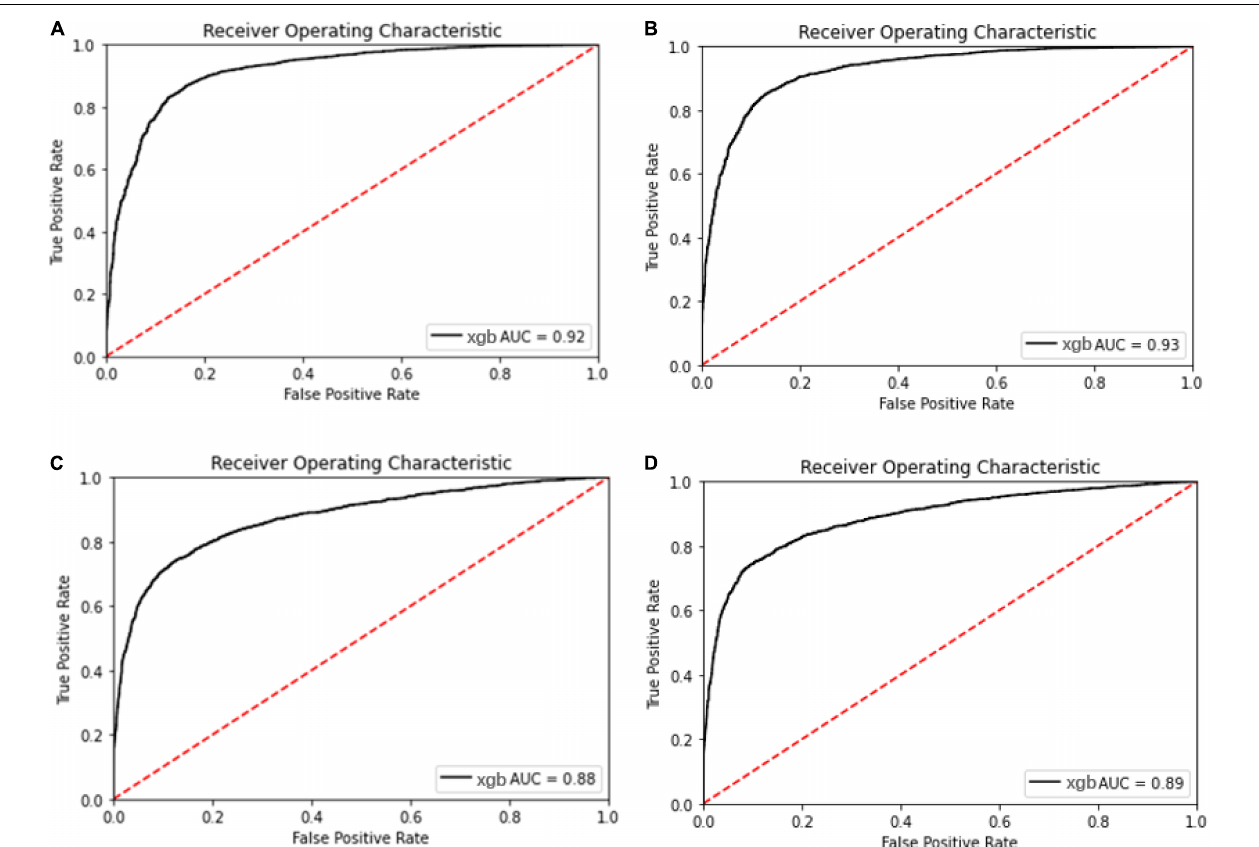
FIGURE 5 | Receiver operating characteristic curve for the oxacillin and clindamycin susceptibility prediction under replication cohort in multi-label learning model, respectively. The AUC is noted in the curve. (A) ROC for the oxacillin susceptibility prediction in replication cohort using XGBoost; (B) ROC for the oxacillin susceptibility prediction in replication cohort using Lowest Power set with XGBoost; (C) ROC for the clindamycin susceptibility prediction in replication cohort using XGBoost; and (D) ROC for the clindamycin susceptibility prediction in replication cohort using Lowest Power set with XGBoost.